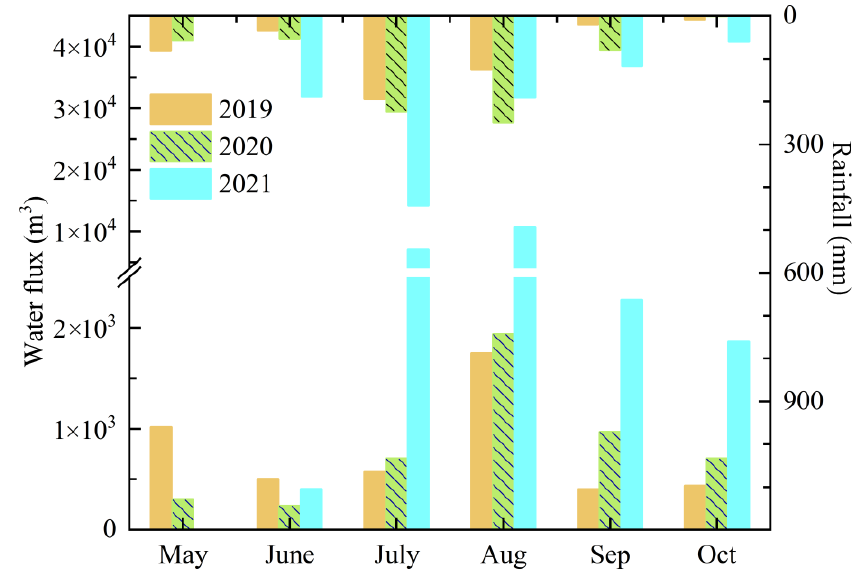
Figure 3. Monthly rainfall and flow of Sha River in high flow season from 2019 to 2021.